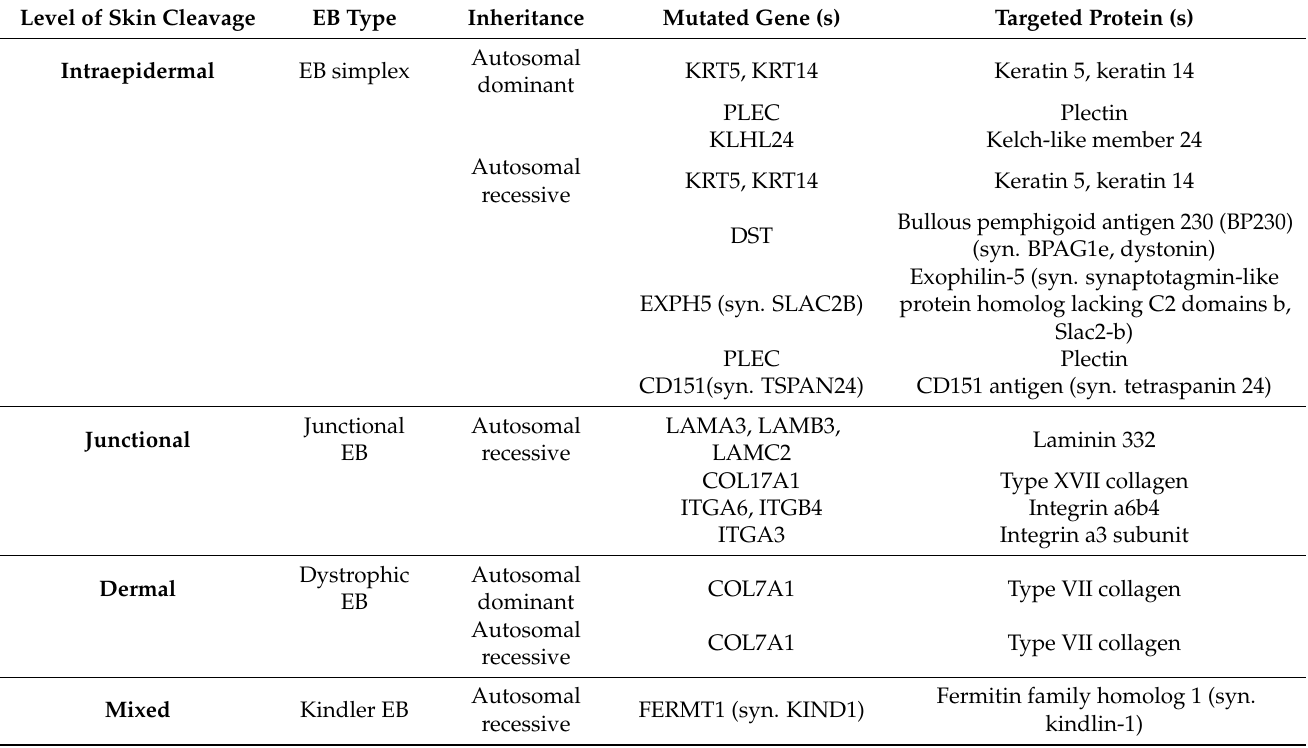
Table 2. Classical types of EB (adapted from Ref.